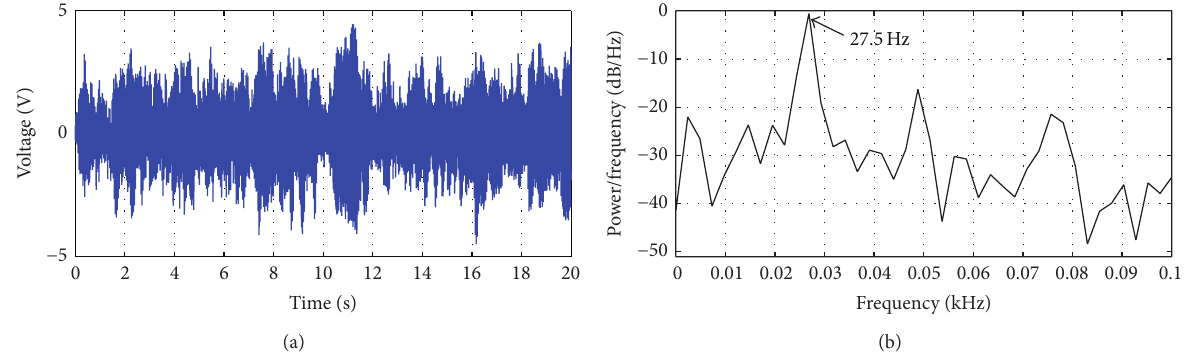
Figure 6: (a) shows time plot of balance signal without control ON and (b) shows the PSD estimation of the time plot.